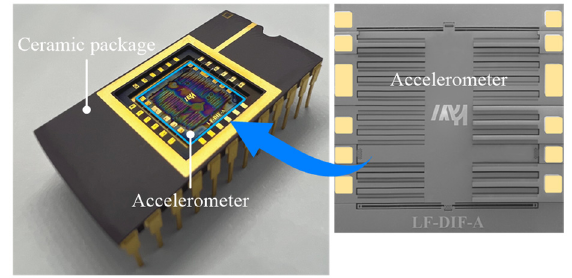
Figure 5. Accelerometer encapsulated by a ceramic package.